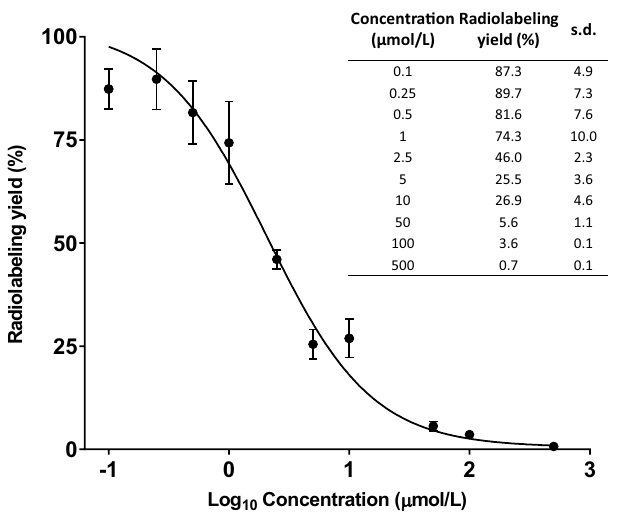
Figure 1. Determination of the average number of NOTA conjugated to each pertuzumab molecule with an isotopic dilution method. r 2 = 0.9715; n = 3; s.d.: standard deviation. The figure was graphed with GraphPad Prism 7.0 (https ://www.graph pad.com/scien tific -softw are/prism